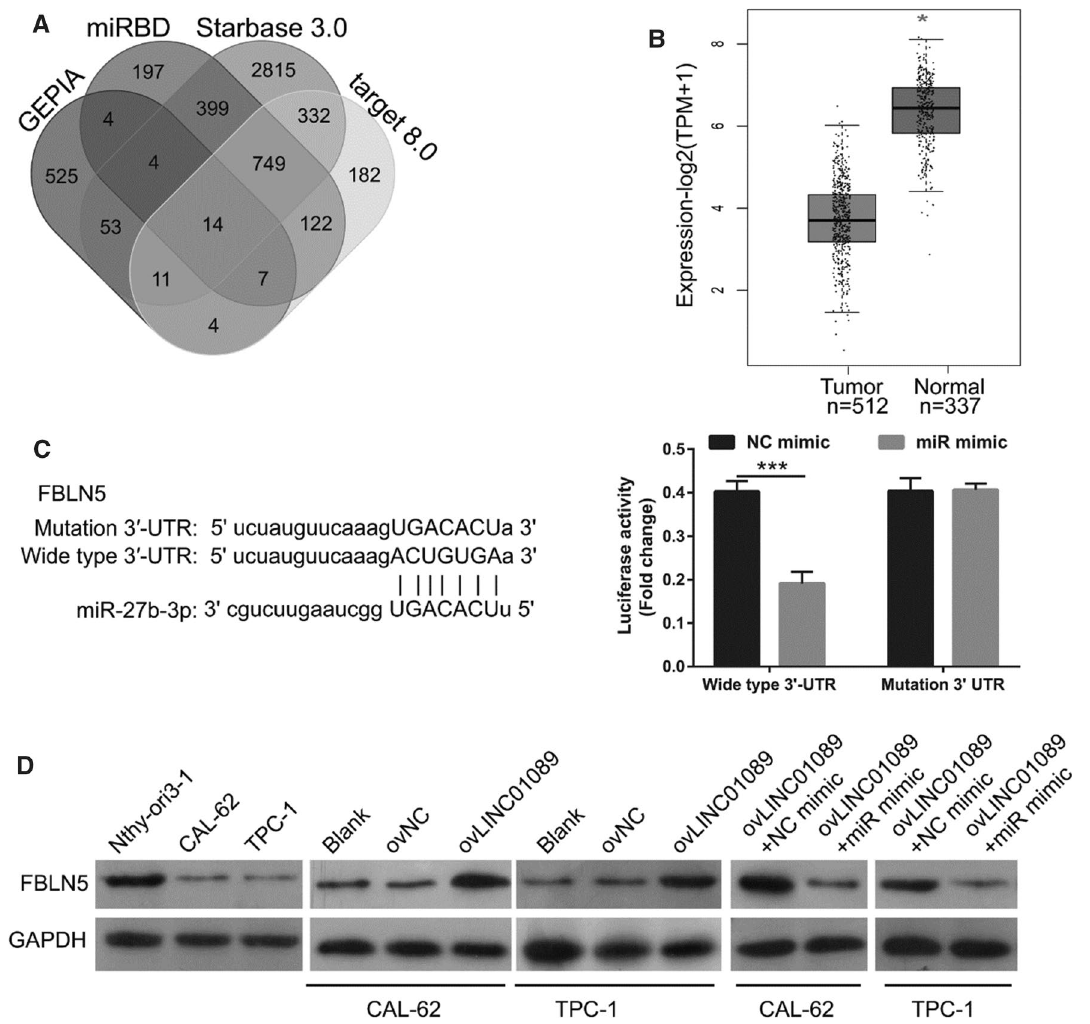
Fig. 5 FBLN5 was the downstream target of LINC01089/miR-27b-3p. A Significantly decreased genes in thyroid cancer were analyzed by GEPIA. Then, the possible target of miR-27b-3p was analyzed by miRDB, Starbase 3.0, and targetscan 8.0. The intersection of the above two sets of results indicated 14 potential target genes. B FBLN5 mRNA expression in thyroid cancer was determined by GEPIA analysis. C The binding between miR-27b-3p and FBLN5 3 ʹ -UTR was analyzed by the luciferase assay. D FBLN5 protein in transfected TPC-1 and CAL-62 cells was analyzed by western blotting at 48 h after